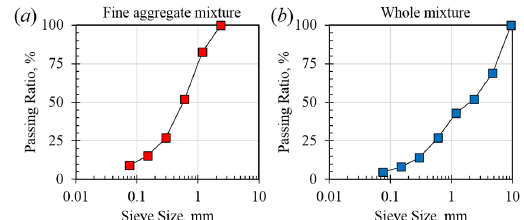
Fig. 2. The grain size distribution of the macroscopic particles our experiments determined by sieving. (a) shows the size distribution of particles 𝑑 (cid:3409) 2.36 mm, and (b) represents the size distribution of the entire mixture.